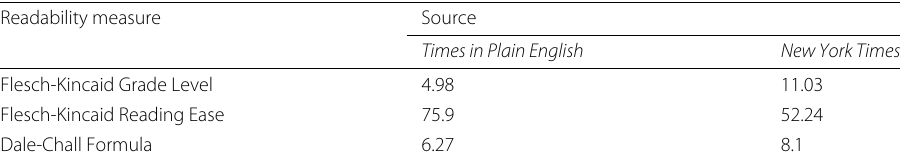
Table 2 Readability measures of two